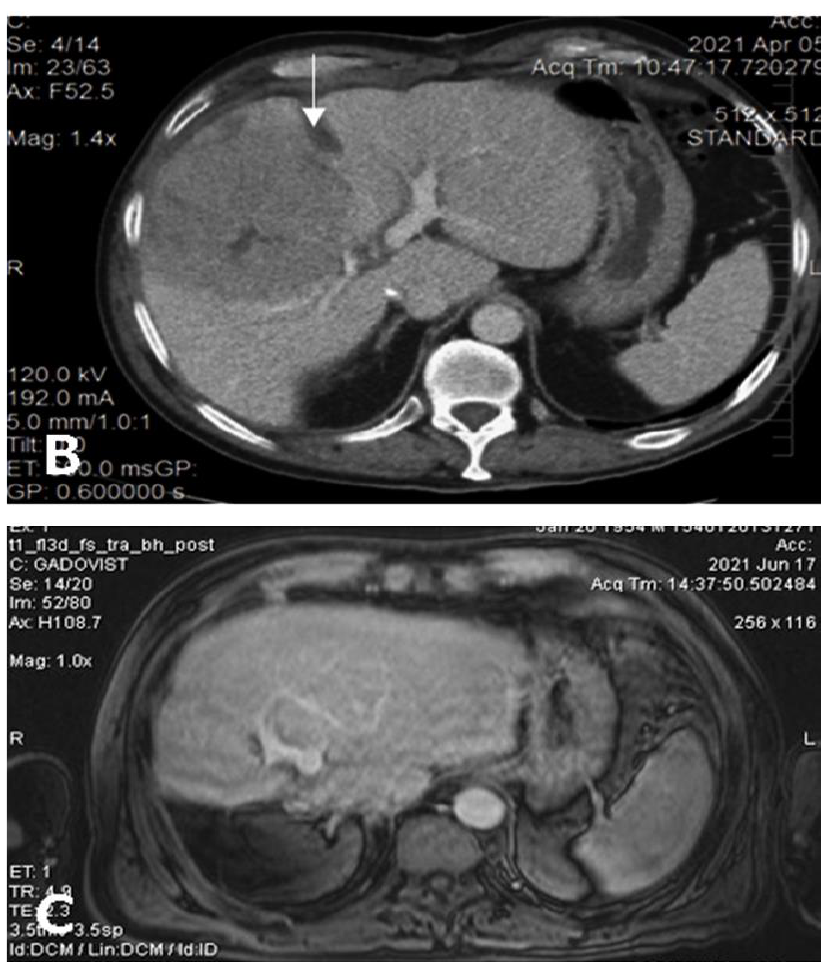
Figure 2. ( A ). Preoperative CT showing the large HCC located in segments 5 and 8 with extension to segments 6, 7, 4, compressing the middle hepatic vein; volumetry: volume of segments 2 and 3, 16.8% of total functional liver volume, volume of FLR 27.8%. ( B ) Interstage CT showing the liver partitioning, absence of contrast in the right portal vein (due to ligation), and sufficient growth of FLR (38.5% of total functional liver volume). ( C ) Postoperative CT with well-perfused, non-dilated bile ducts, and tumor-free remnant liver.